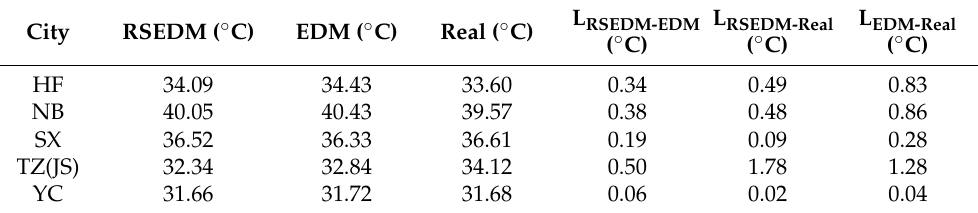
Table 3. Background land surface temperature fitted by the rotational-scan exponential decay model and exponential decay model of the first category of cities, and the difference between fitted temperature and the real temperature. Difference values in the table are absolute terms.